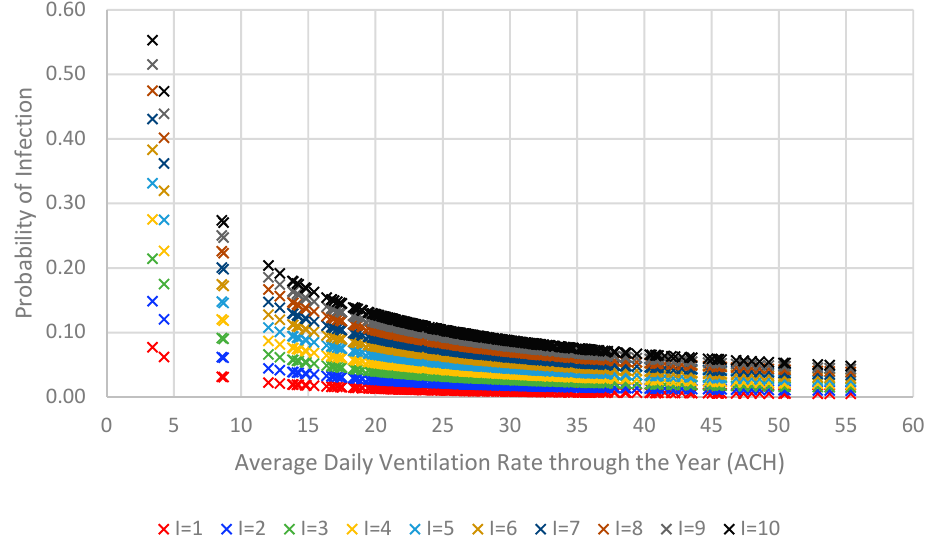
Figure 8. Impact of number of patients on the probability of infection for the naturally ventilated historical house in Jeddah.